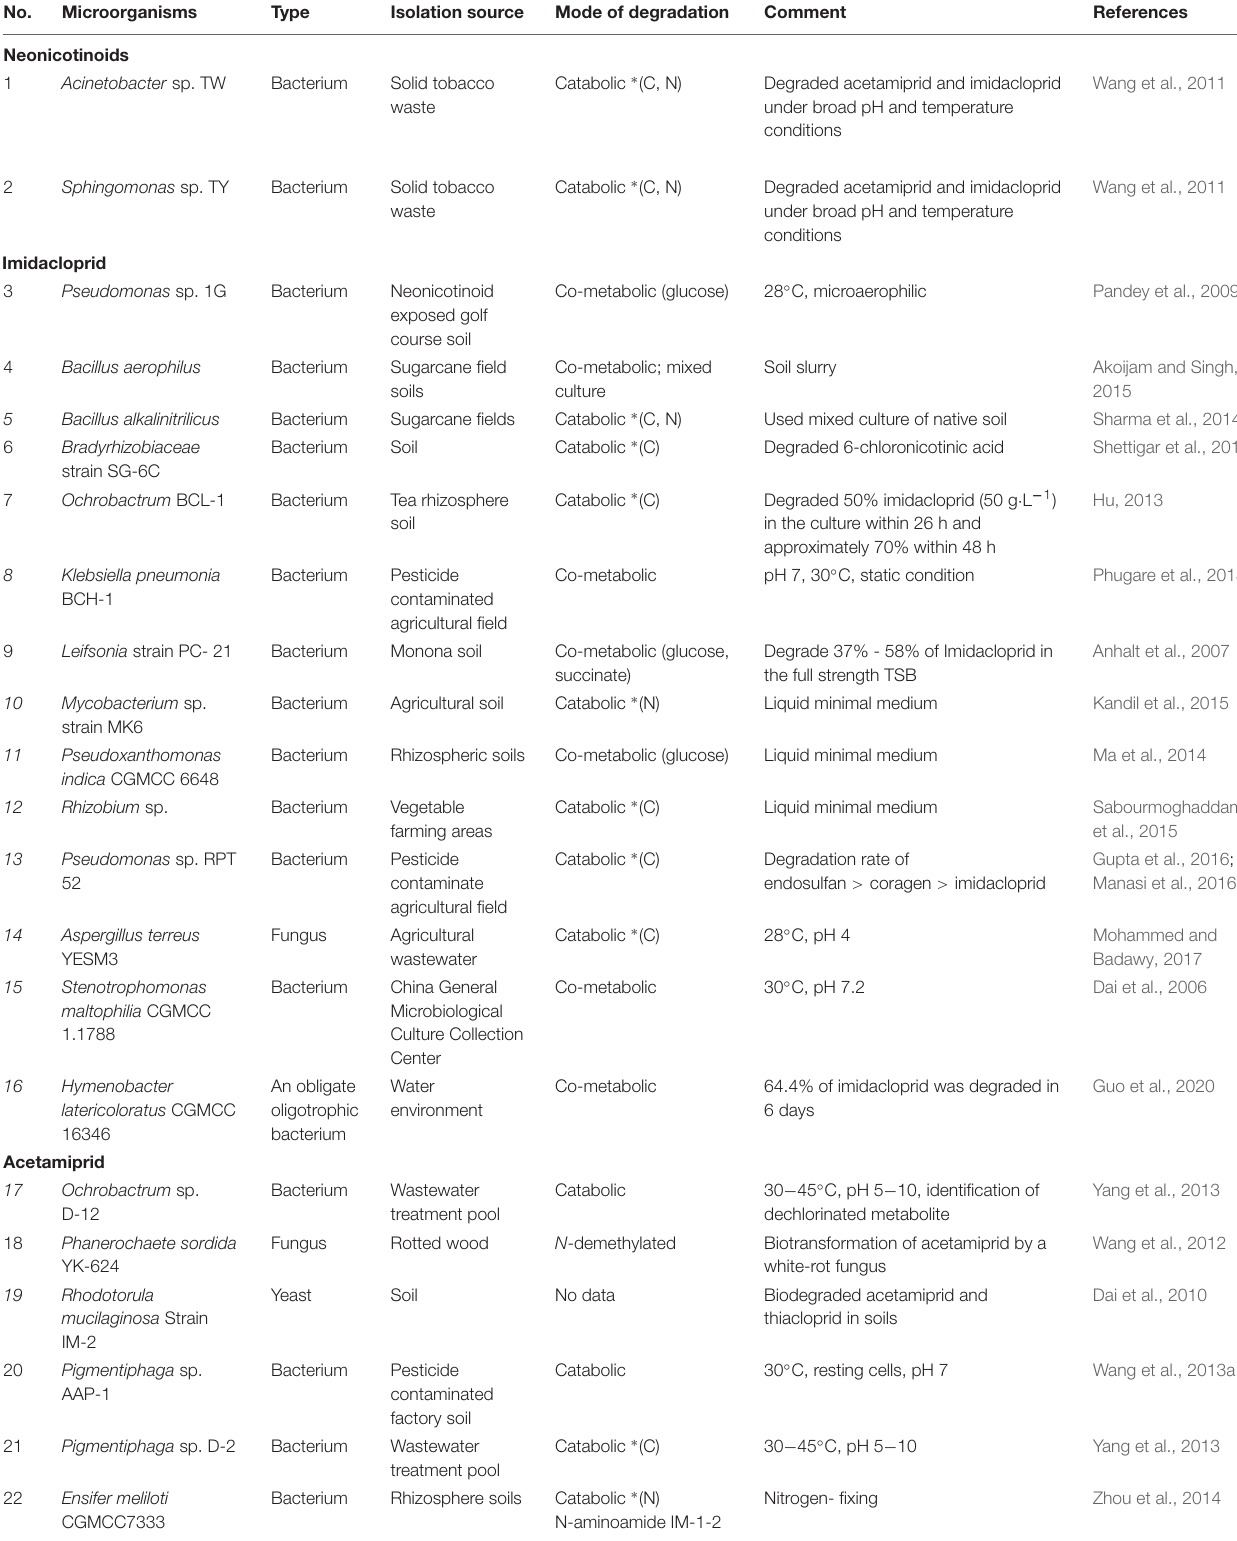
TABLE 3 | Degradation studies of neonicotinoid compounds by isolated microorganisms.